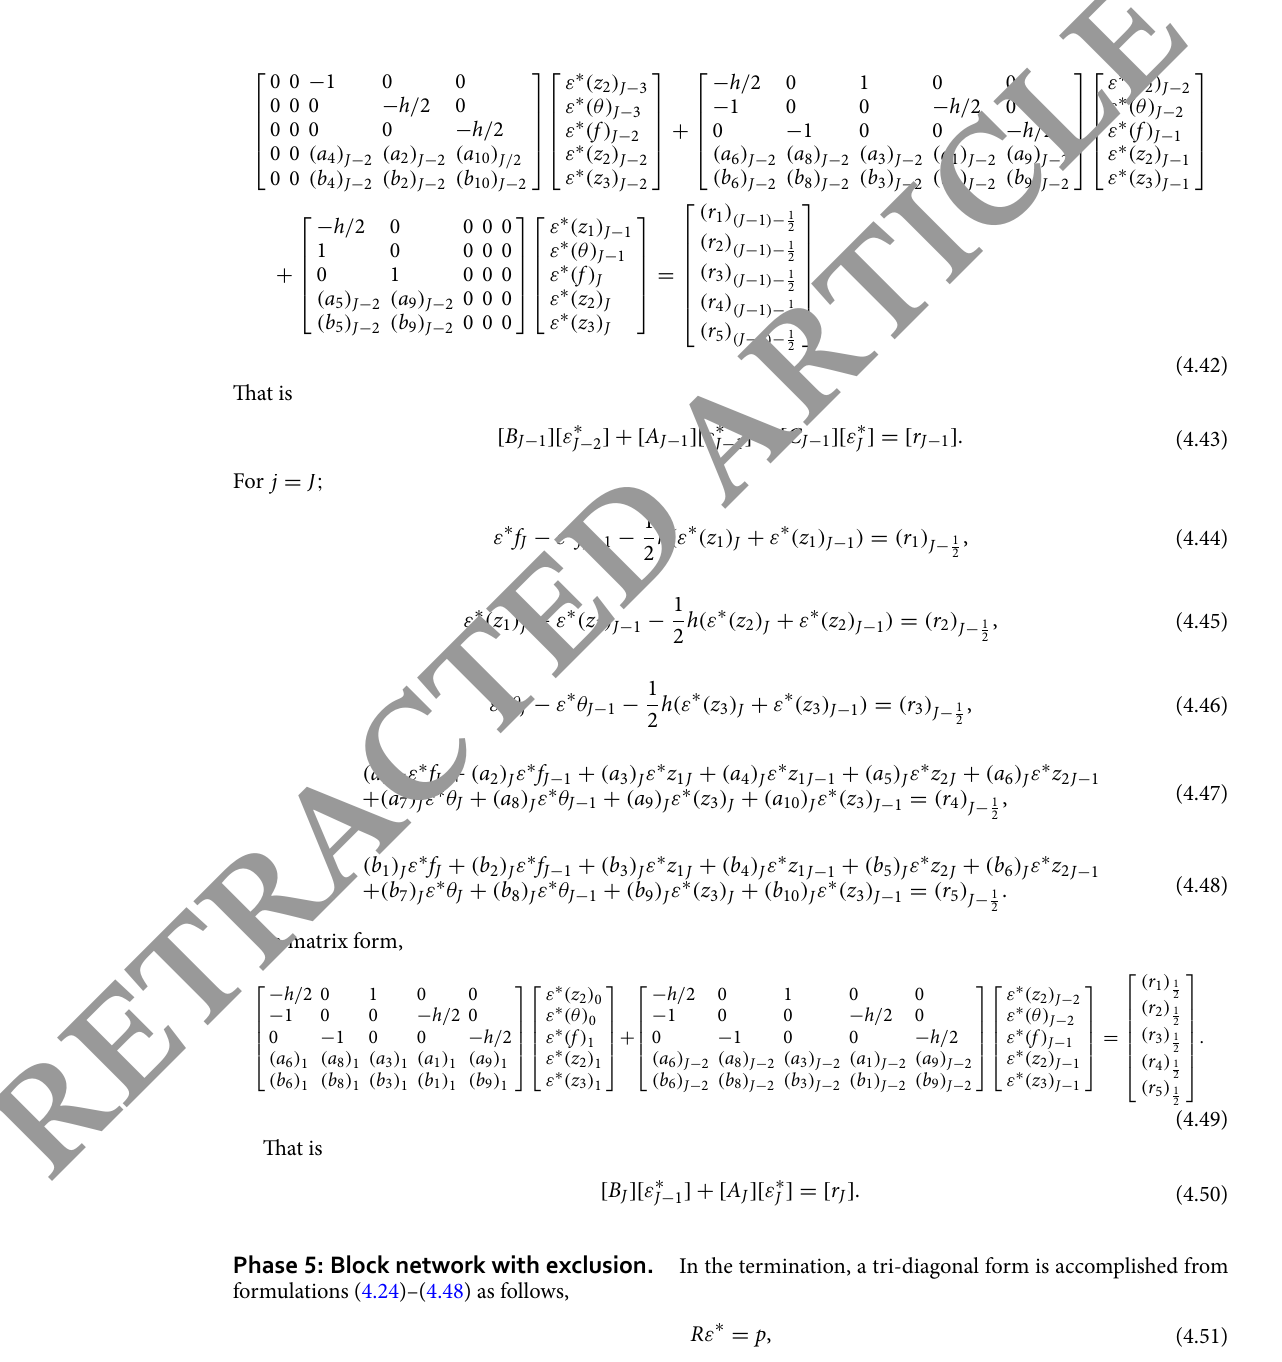
θ ′ ( 0 ) with varied Prandtl number, φ − 0 i =